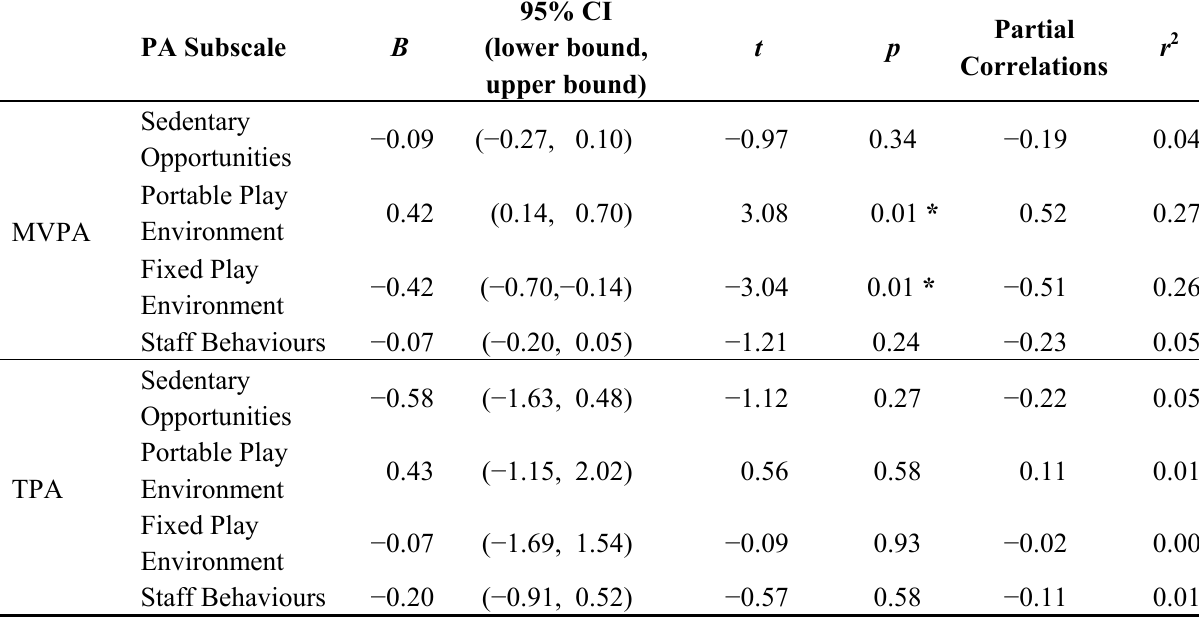
2. Summary of Coefficients, Confidence Intervals, t -values, p -values, 95% CI Partial r 2 PA Subscale B (lower bound, t p Correlations upper bound) Sedentary − 0.09 ( − 0.27, 0.10) − 0.97 0.34 − 0.19 0.04 Opportunities Portable Play 0.42 (0.14, 0.70) Environment MVPA Fixed Play − 0.42 ( − 0.70, − 0.14) 0.26 Environment Staff Behaviours − 0.07 ( − 0.20, 0.05) 0.24 − 0.23 − 0.58 ( − 1.63, 0.48) Opportunities 0.43 Environment Fixed Play − 0.07 ( − 1.69, 1.54) Environment Staff Behaviours − 0.20 ( − 0.91, 0.52) 0.58 − 0.11